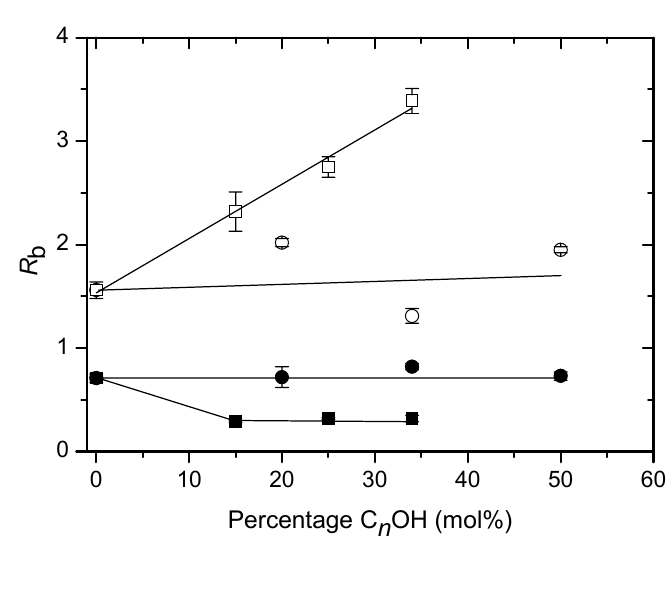
( □ ) 0 mol% R Lines are drawn to guide the eye